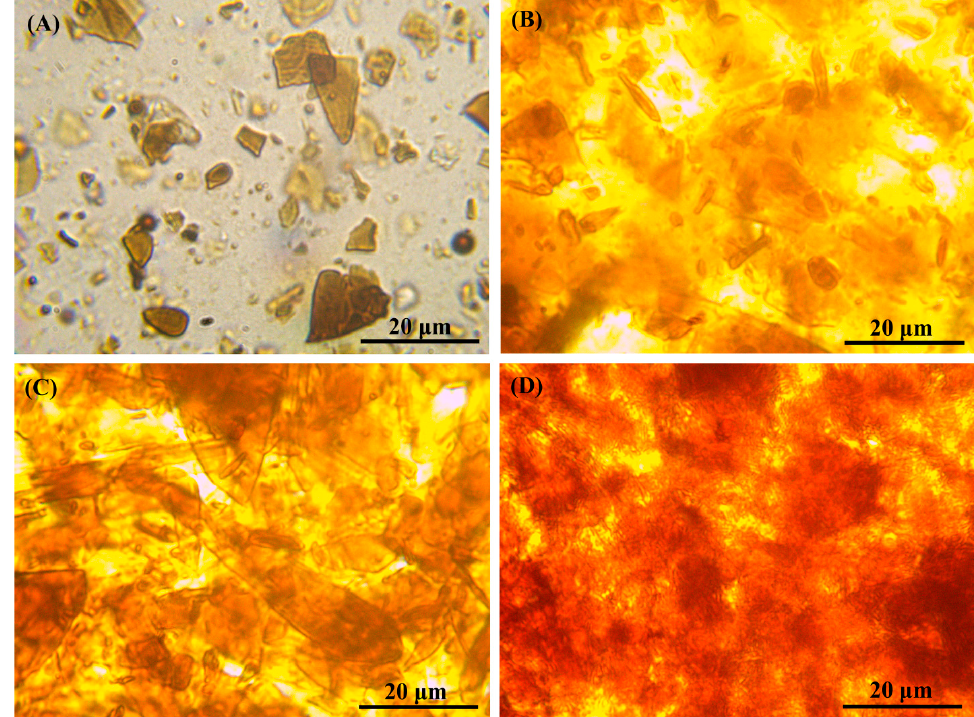
Figure 11. Microphotographs of PIB containing 5 ( A ), 10 ( B ), 20 ( C ), or 30 ( D ) wt% of asphaltenes.